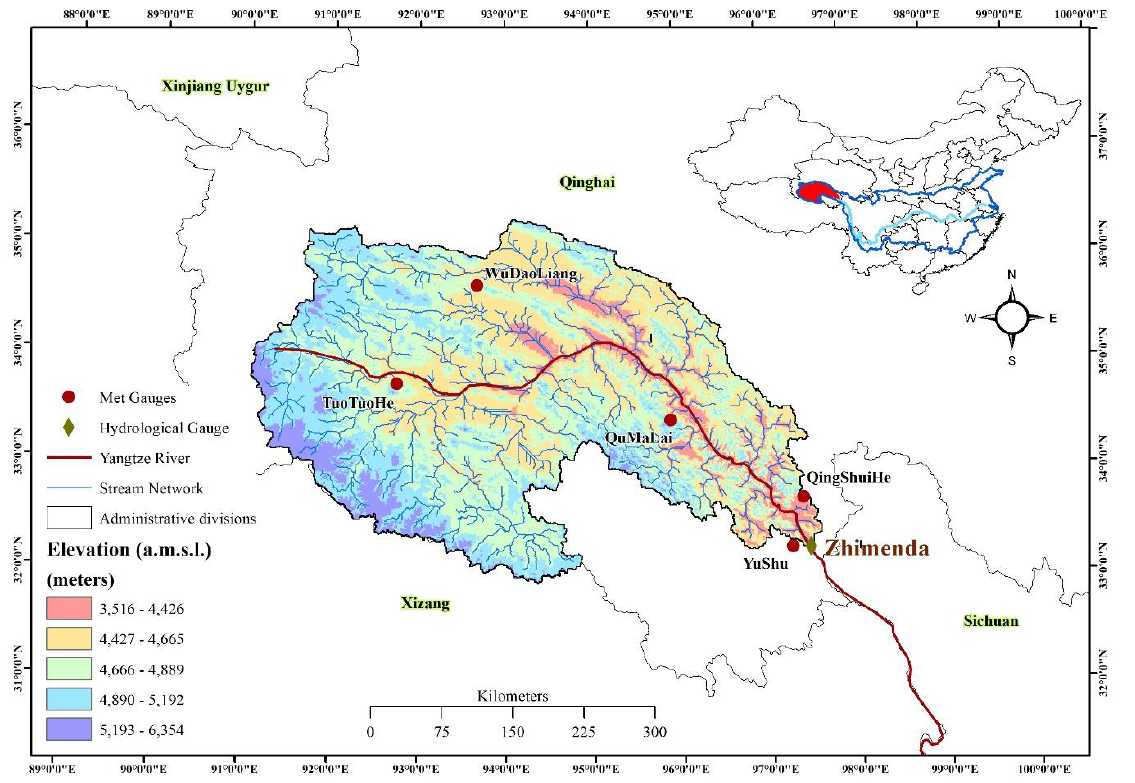
Figure 1. The Yangtze River Source Region (YRSR) with hydrological and meteorological stations.